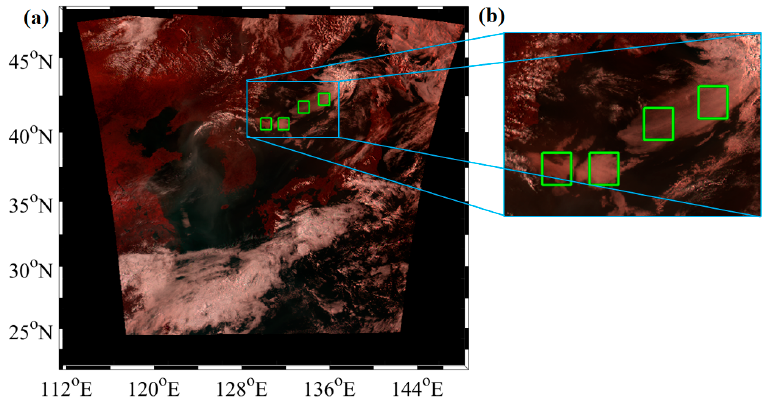
Figure 1. Setting dataset areas in a Geostationary Ocean Color Imager (GOCI) image. Image is composited with an RGB composition (R-8, G-2, B-1): ( a ) land, cloud, seafog and oceans have colors red, bright pink, dark pink, and black, respectively; ( b ) green squares are the areas of sea fog dataset extraction, with a size of 100 × 100 pixels.